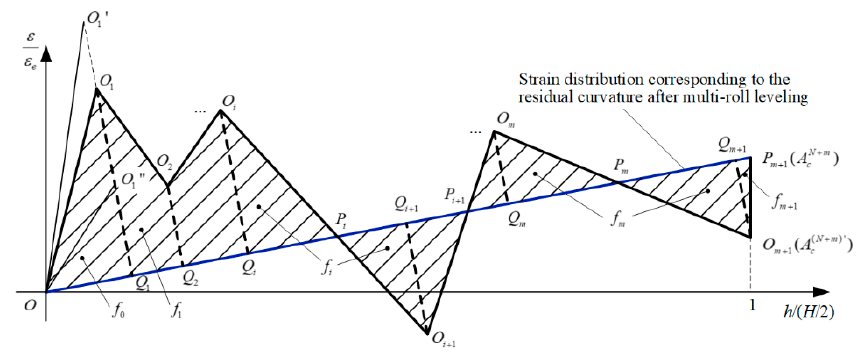
Figure 6. Distribution of the residual stress after multi-roll levelling.